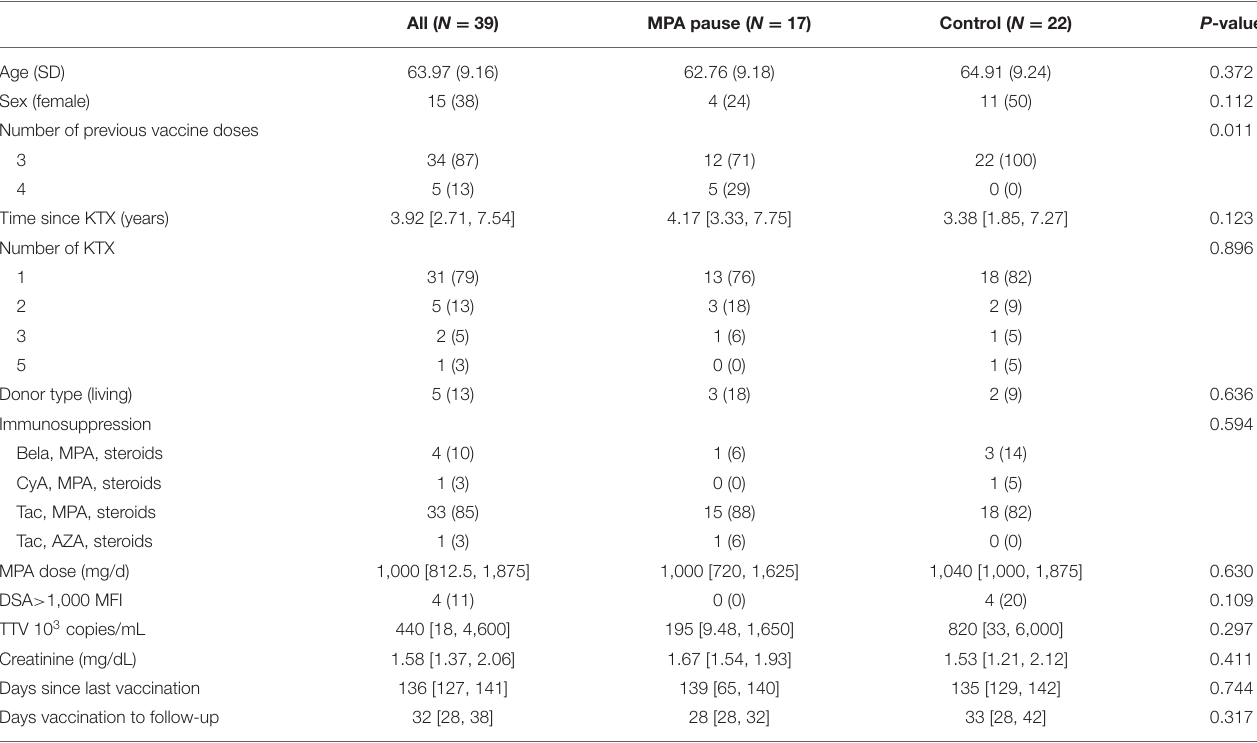
TABLE 1 | Baseline